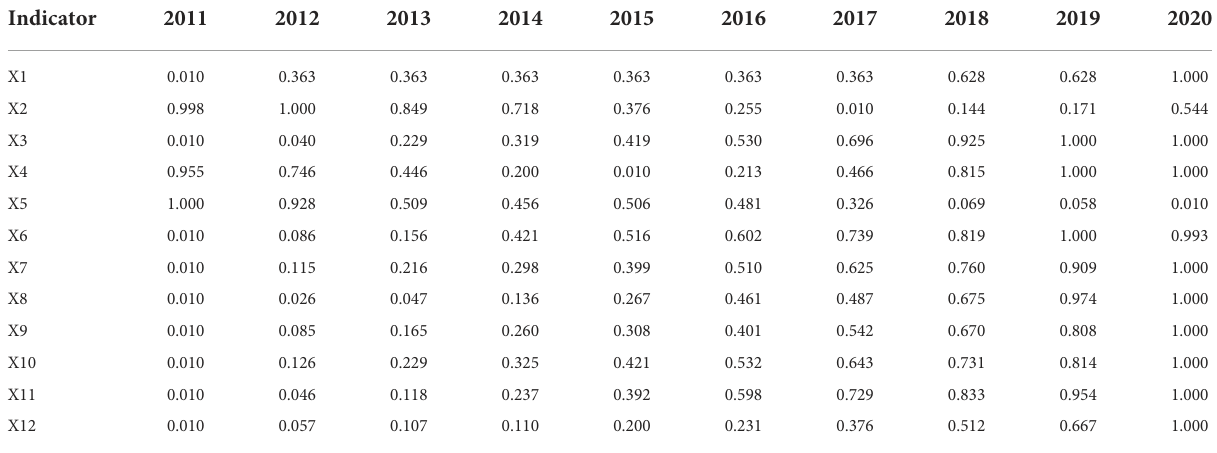
TABLE 6 The standardized values of each indicator from 2011 to 2020.